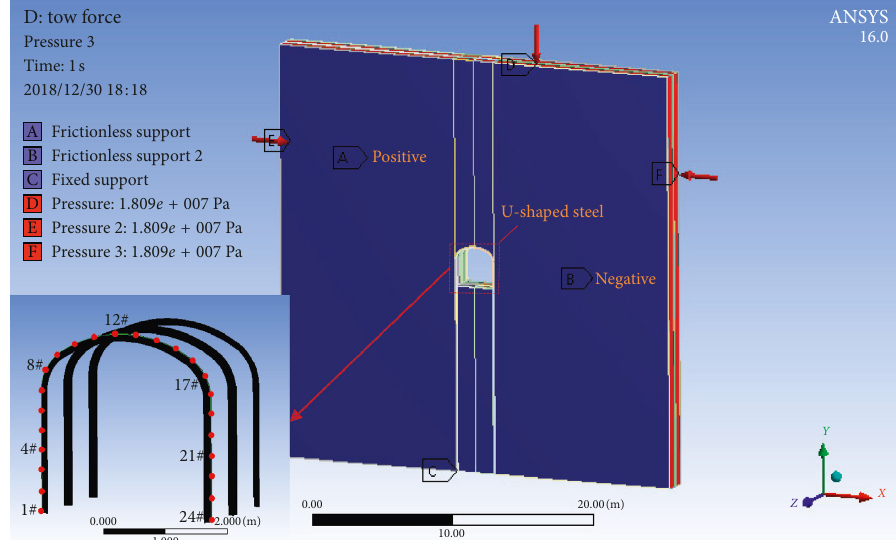
Figure 3: Coupling model of U-shaped steel and surrounding rock. The boundary conditions and 24 monitoring points are represented with A to F and red